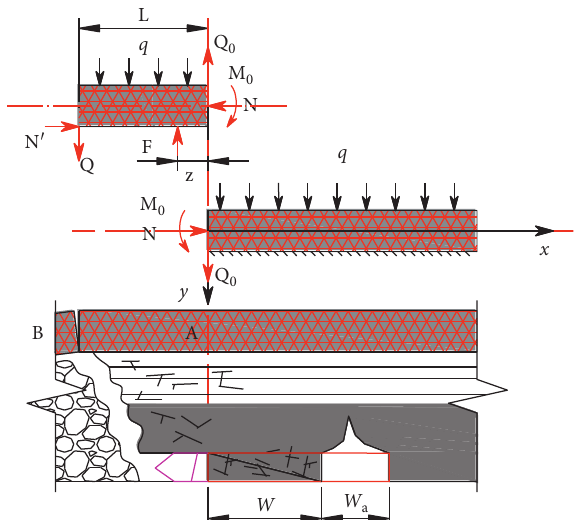
Figure 9: The mechanical model of the main roof.